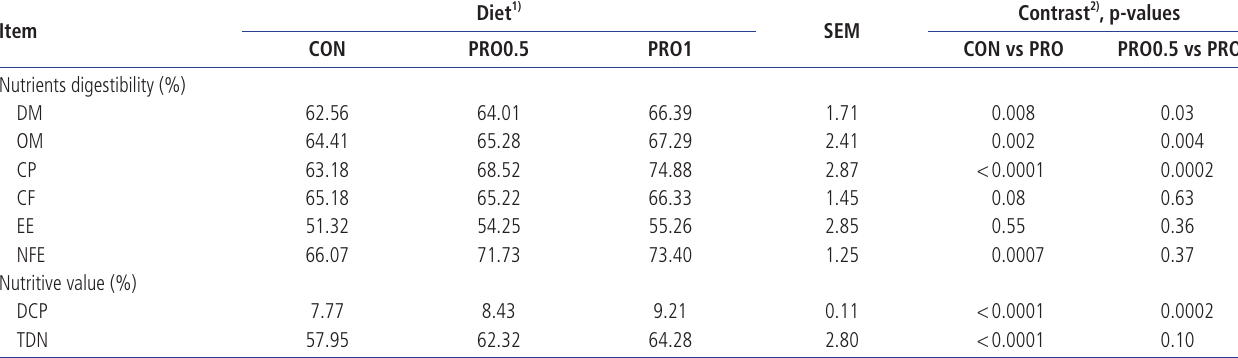
Table 6. Effect of feeding probiotic (PRO) supplemented diet to lambs on digestibility and nutritive value of experimental